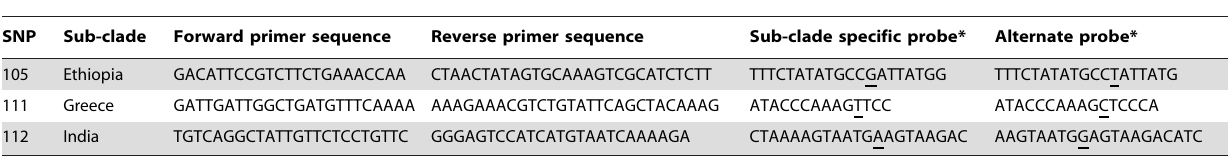
Table 3. Sequence for TaqMan primers and probes for defining castor bean chloroplast